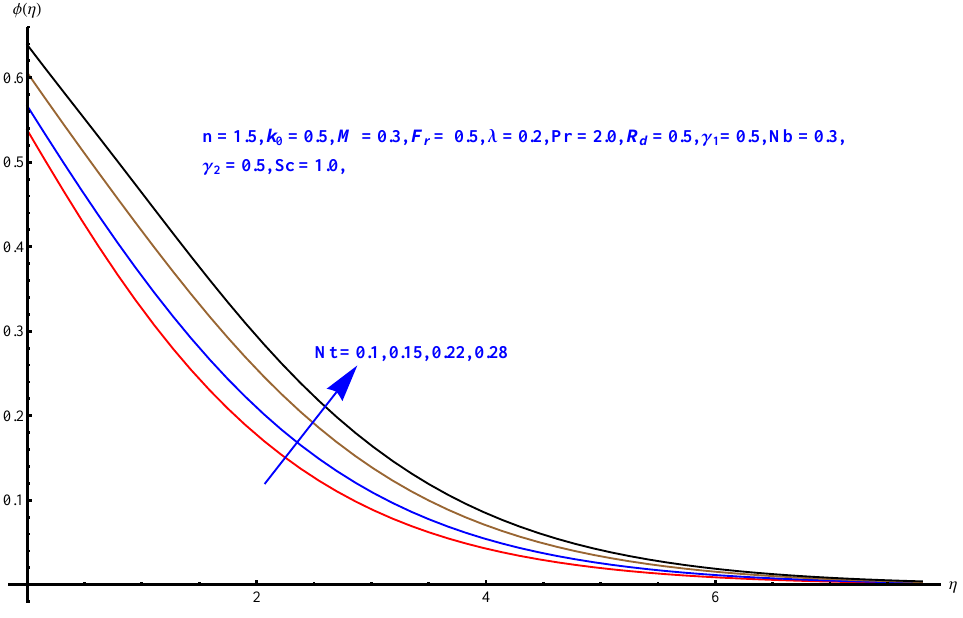
Figure 11. Thermophoresis versus concentration